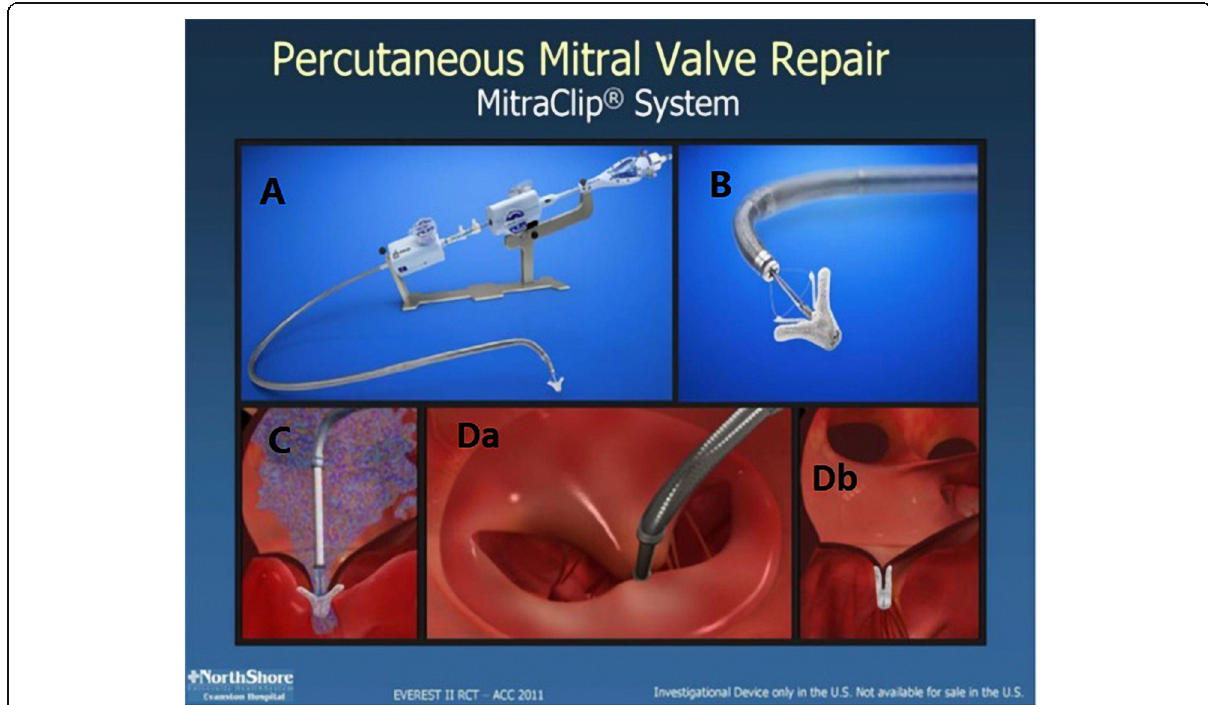
Fig. 1 The MitraClip ™ Percutaneous Edge-to-Edge Repair System. The MitraClip ™ delivery system (Abbott Vascular, Abbott Park, IL) showing a steerable guide catheter, a clip delivery system, and the MitraClip ™ device ( a ). The MitraClip ™ device is a polyester-covered cobalt-chromium implant with two arms, while the U shaped grippers are placed in the inner portion of the clip that helps with leaflet fixation ( b ). The clip delivery system exits through a guide catheter, to grasp the mitral valve leaflet at the site of MR ( c ). When the clip is closed, the leaflet tissue is secured by the clip arms on ventricular side and by the grippers on the atrial side, creating a double-orifice valve ( d